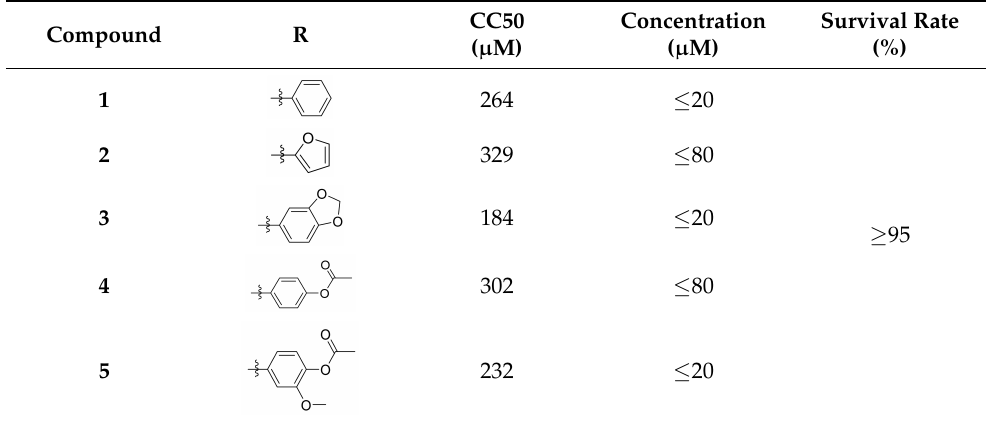
Table 2. The CC50 and safe concentration range of 1-methylhydantoin cinnamic imides on RAW264.7 cells.